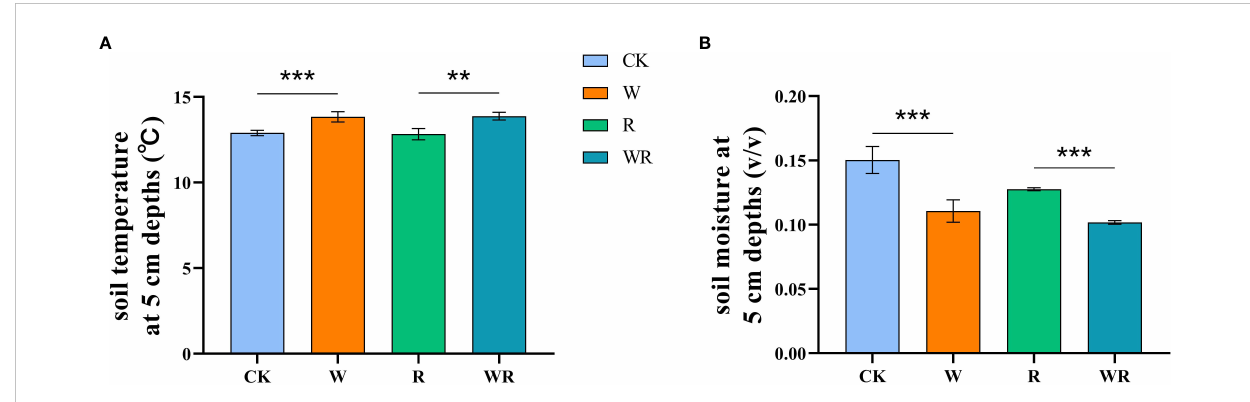
FIGURE 2 Soil temperature (°C) and moisture (v/v) at 5 cm depths under four treatments with the result of t-test. CK, control; W, warming; R, reclamation; WR, warming under reclamation. Mean ± Standard error (n = 4) was shown in the fi gure. (*0.01< p < 0.05; **0.001< p < 0.01; *** p < 0.001).